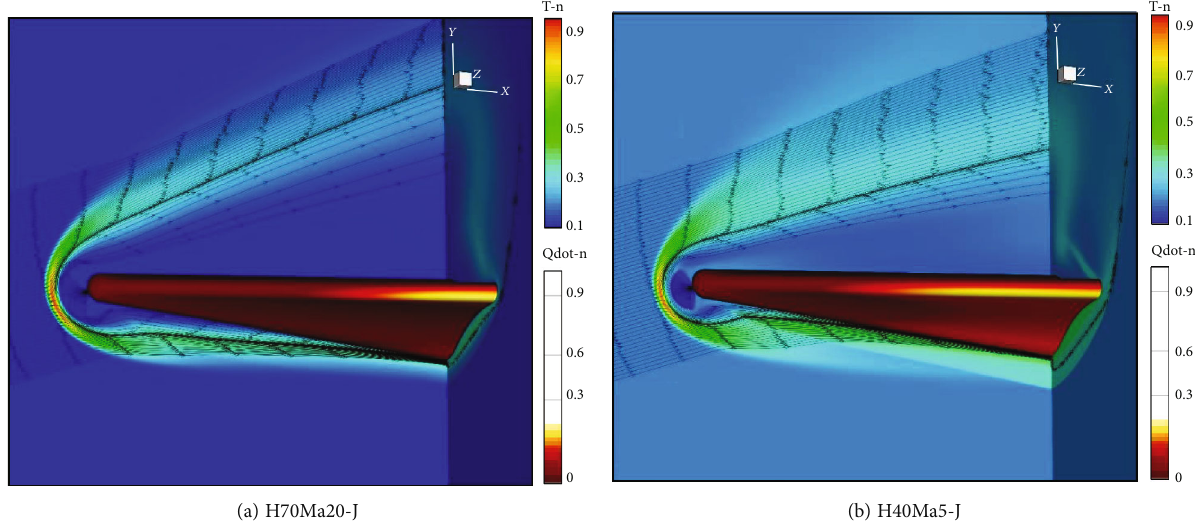
Figure 12: Normalized fl ow fi eld temperature contour and streamlines and model surface heat fl ux contour of two di ff erent fl ight